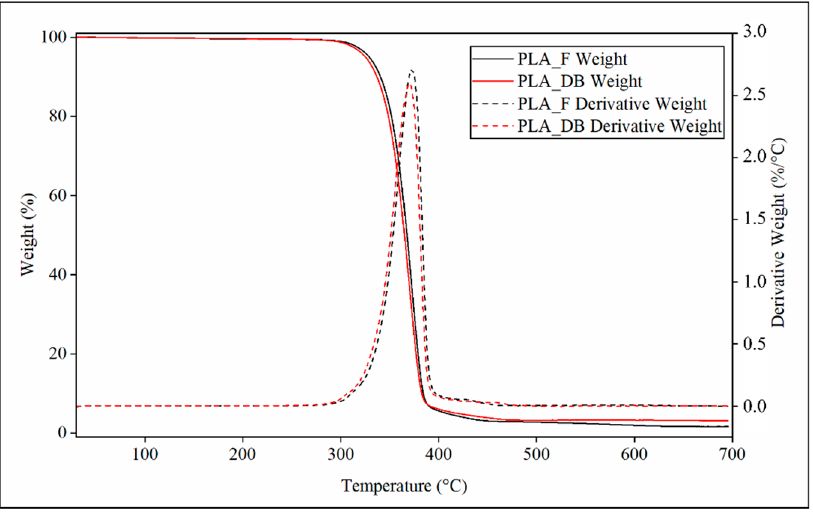
Figure 8. TGA characterization: representative thermograms relevant to profile of weight (continuous line) and derivative weight (dotted lines) of PLA_F (black curves) and PLA_DB sample (red curve).